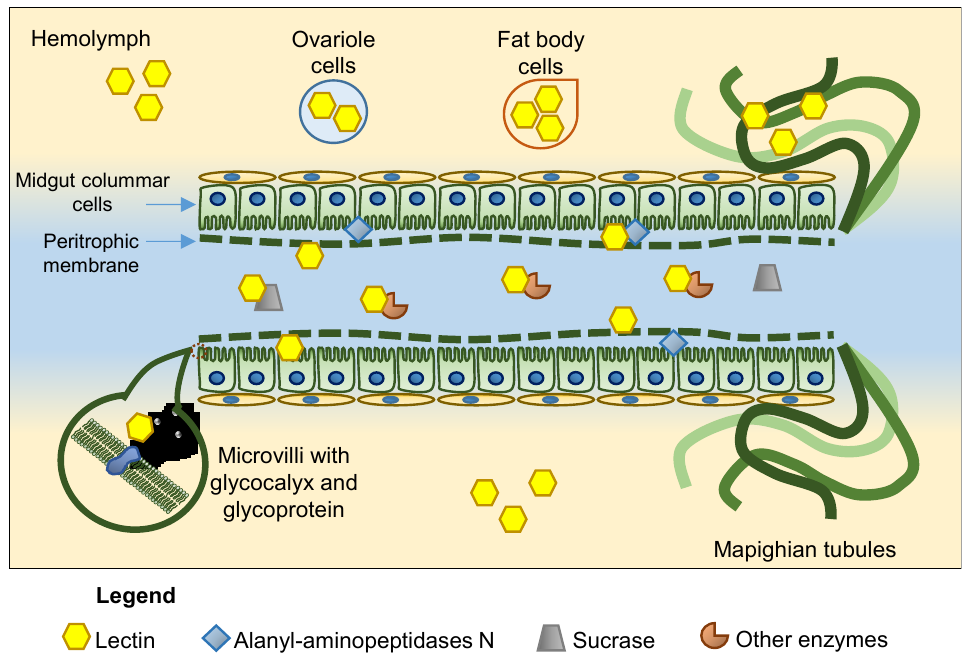
Figure 1. Representative scheme showing the binding sites of plant lectins that have been reported. In addition to the sites displayed in the figure, other receptors are also known: α-amylase, α- and β-glucosidases, trypsin-like enzymes, ferritin, NADH quinone oxidoreductase, vacuolar ATPase; sarcoplasmic reticulum type calcium ATPase, heat shock protein 70, β-subunit ATP synthase and Clathrin heavy